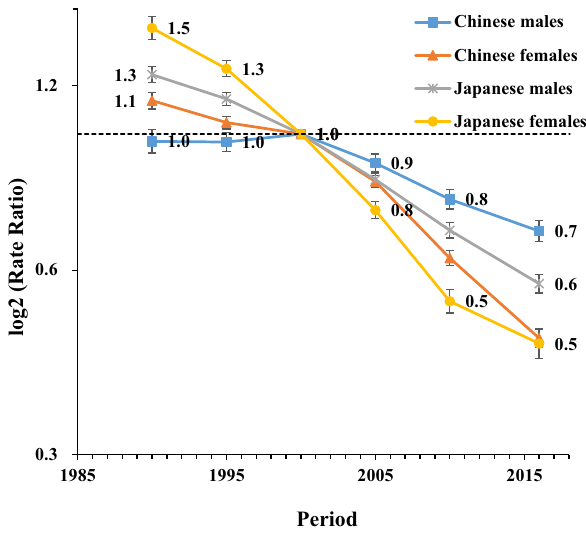
Figure 5. Period relative risks (RRs) of high SBP-attributable stroke mortality rate by sex in China and Japan. The relative risk of each period compared with the reference one (the year 2000) adjusted for age and nonlinear cohort effects. Error bars represent the 95%CIs for the period relative risks. Japanese men 1990: Population: 38 067 229; Stroke: 38 690, 1995: Population: 40 061 997; Stroke: 43 172, 2000: Population: 42 325 105;